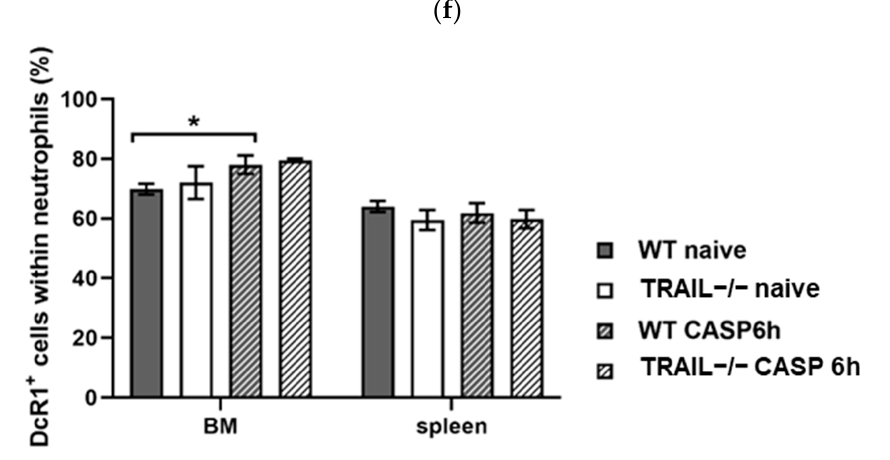
Figure 7. Effect of 6h CASP treatment on the expression of TRAIL receptors. TRAIL receptors DR5, DcR1, and DcR2 were stained and assessed by FACS. Representative FACS plots show ( a ) DR5 staining in neutrophils derived from BM and spleen, ( c ) DcR2 staining in neutrophils of the spleen, and ( e ) DcR1 staining in neutrophils of the BM. Quantification of ( b ) DR5, ( d ) DcR2, and ( f ) DcR1 expression in neutrophils of the BM and spleen of n = 5 animals in each group. Neutrophils of septic WT and TRAIL–/– mice were compared with naïve ones. Graphs show mean ± SEM (* p < 0.05, ** p < 0.01).